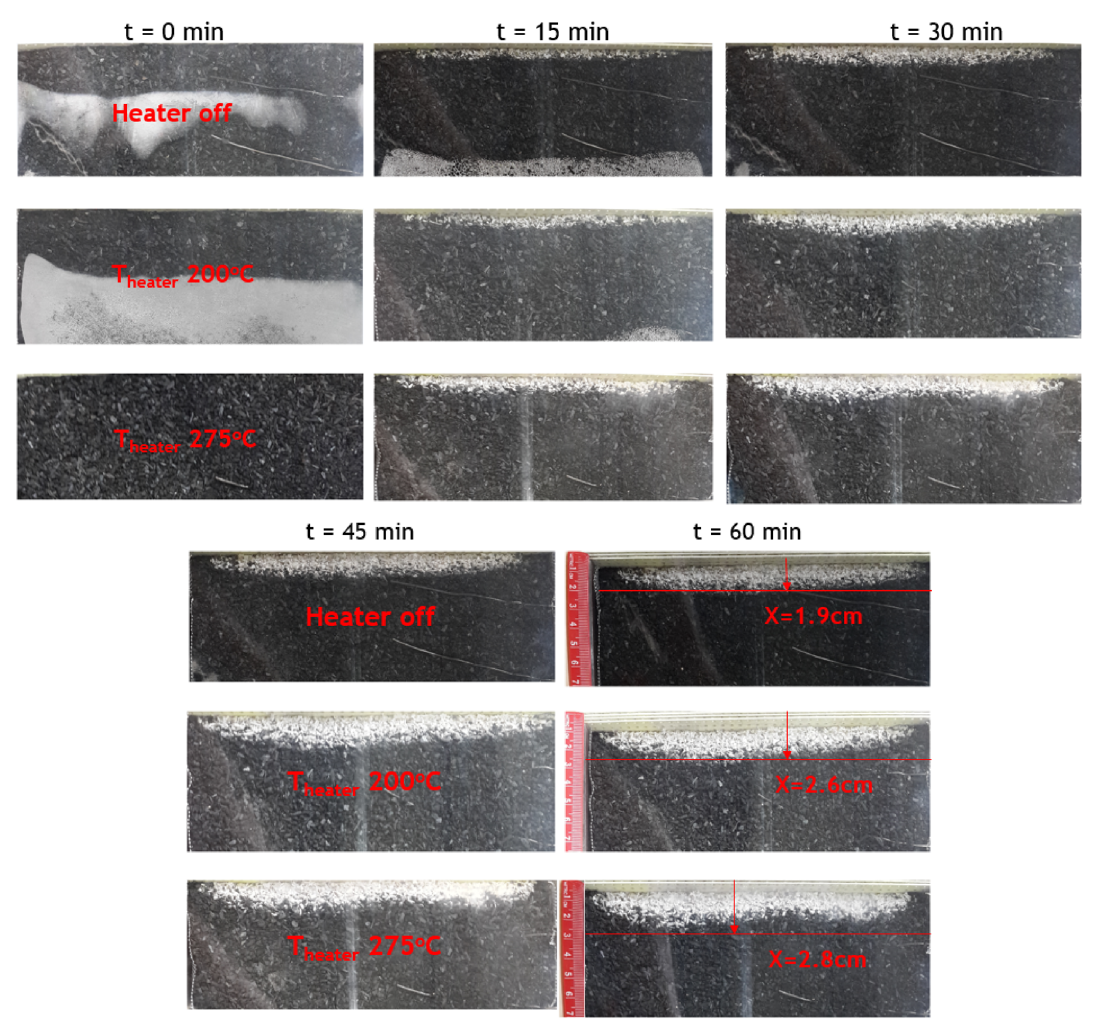
Fig. 12 Reaction front propagation of surface coal packed bed for coal